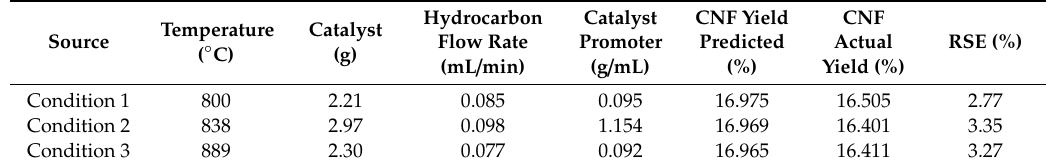
Table 5. Predicted results by